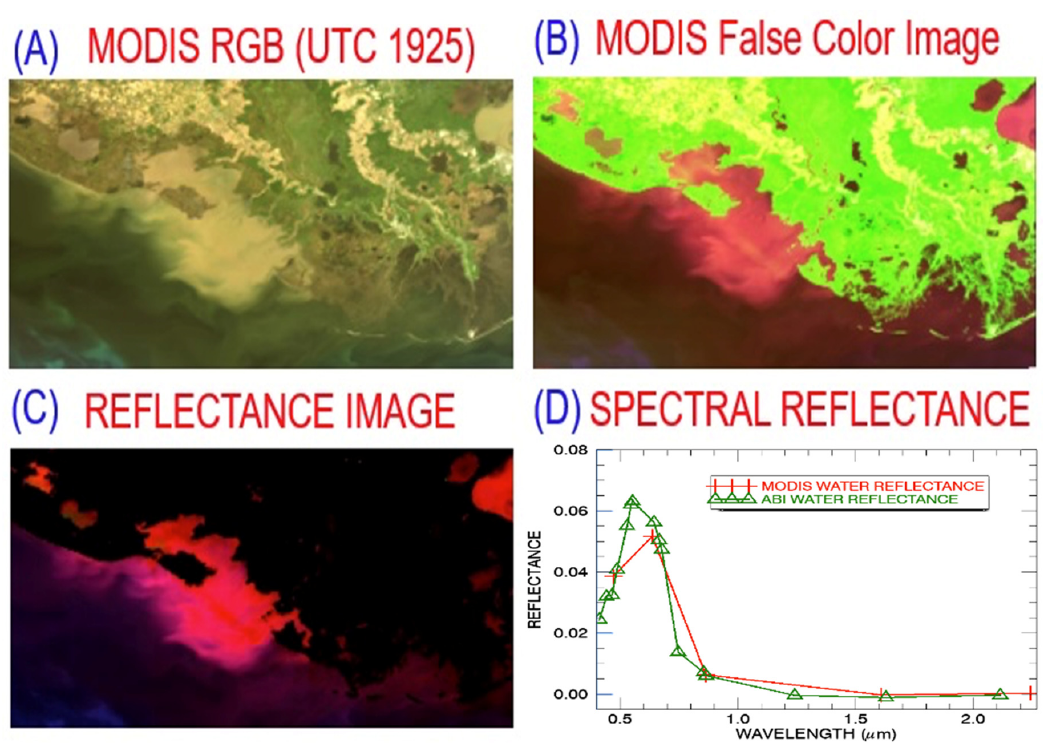
Figure 6. ( A , B )—true color and false color moderate resolution imaging spectroradiometer (MODIS) Figure 6. ( A ) and ( B ) — true color and false color moderate resolution imaging spectroradiometer images acquired near the Gulf of Mexico at UTC 1925 on March 20, 2019; ( C )—the corresponding (MODIS) images acquired near the Gulf of Mexico at UTC 1925 on March 20, 2019; ( C ) — the derived water surface reflectance images; and ( D )—water leaving reflectances derived from ABI corresponding derived water surface reflectance images; and ( D ) — water leaving reflectances derived (dashed green curve) and from MODIS data (solid from ABI (dashed green curve) and from MODIS data (solid line).